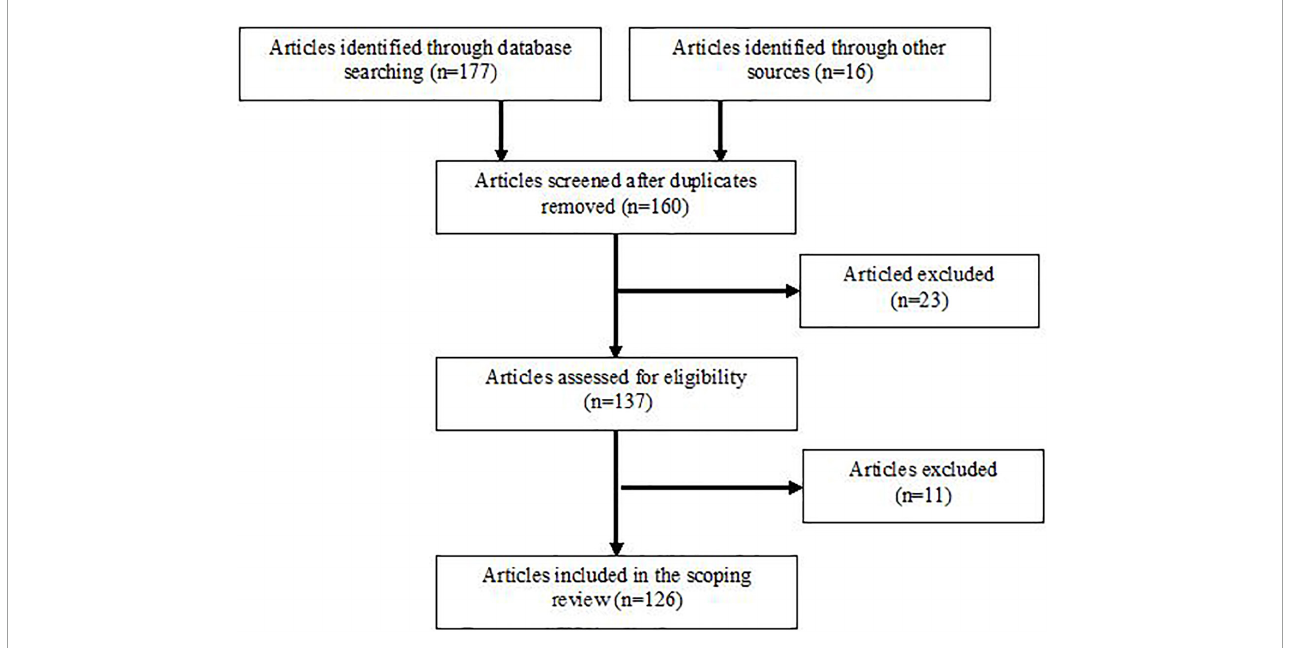
FIGURE1 Flow chart illustrating phases of the literature search and study